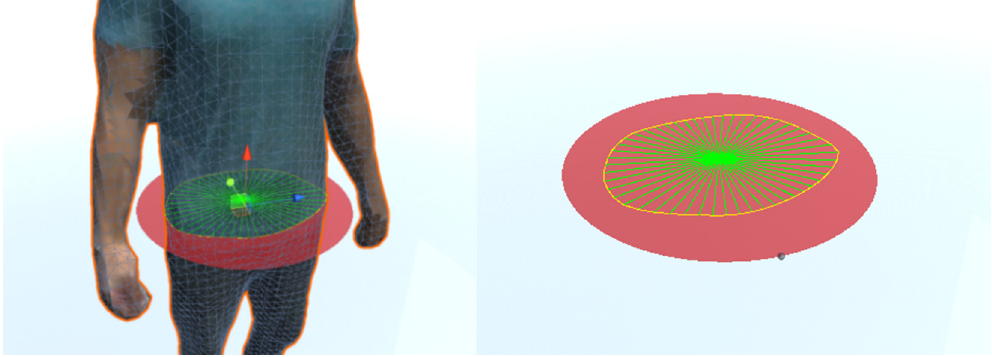
Figure 10. Triangulation of the area enclosed in the perimeter.